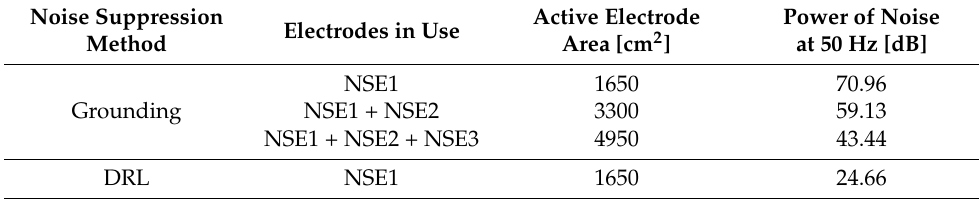
Table 3. The common-mode power of different noise suppression